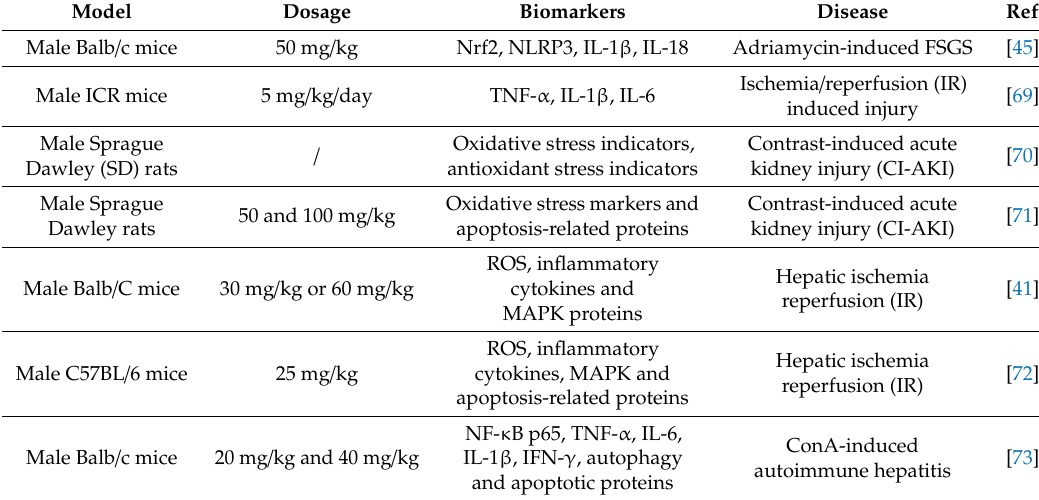
Table 3. The anti-inflammatory e ff ects of astaxanthin in hepatic and renal diseases.